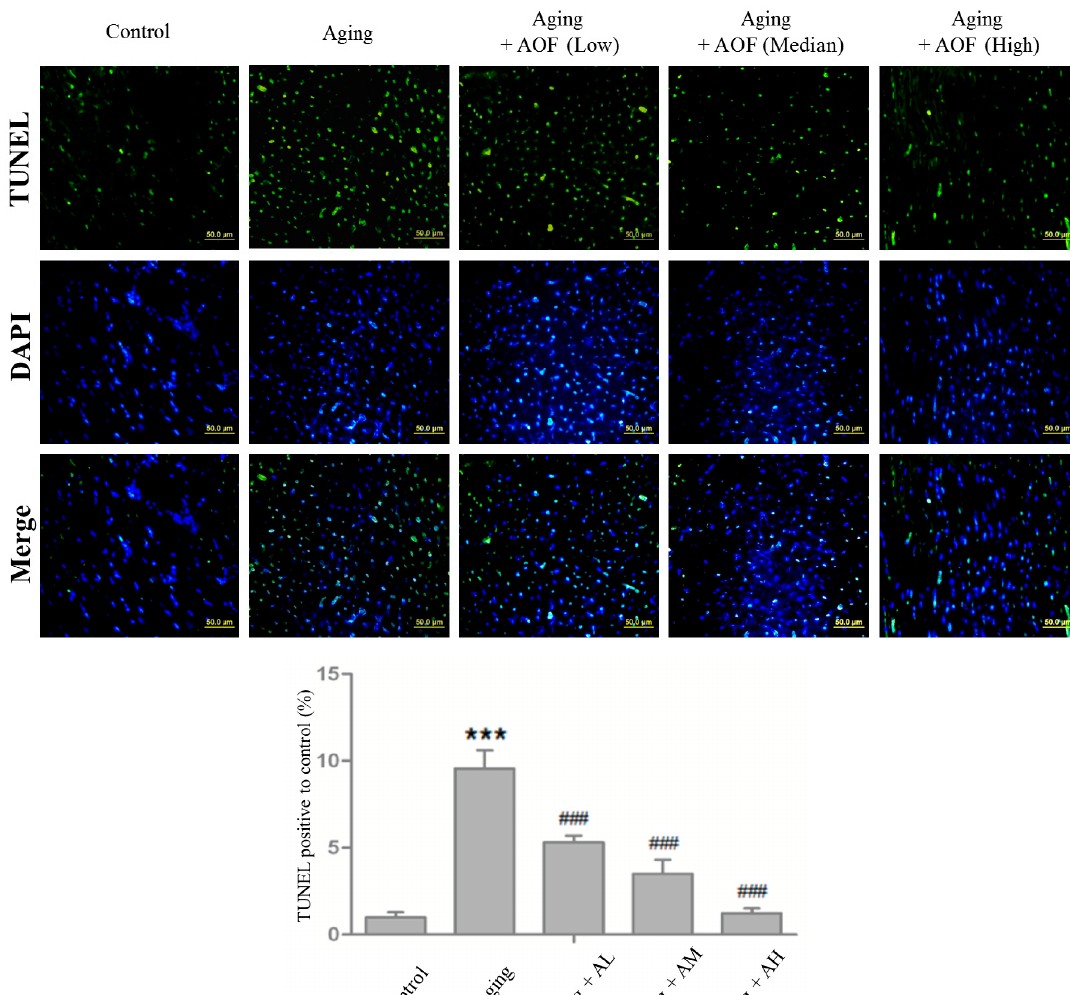
Figure 3. AOF treatment inhibits D -galactose-induced aging and apoptosis in Sprague–Dawley (SD) rat cardiac tissue. Cardiac tissue sections were stained with 4,6-diamidino-2-phenylindole (DAPI) (blue, nucleus) and TUNEL assay (green, double-stranded DNA break or single-stranded DNA nicks.), respectively. The statistical results were shown from three independent experiments; mean ± S.D.; *** p < 0.001, represent a significant difference versus the control; ### p < 0.001, represent a significant difference versus the aging group.